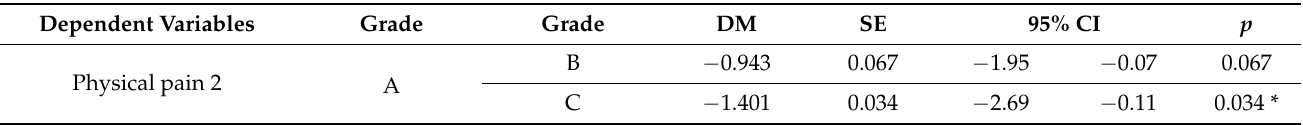
Table 2. ANOVA of the significant dependent variables (post-treatment: 2) with respect to the grade of periodontal disease (A,